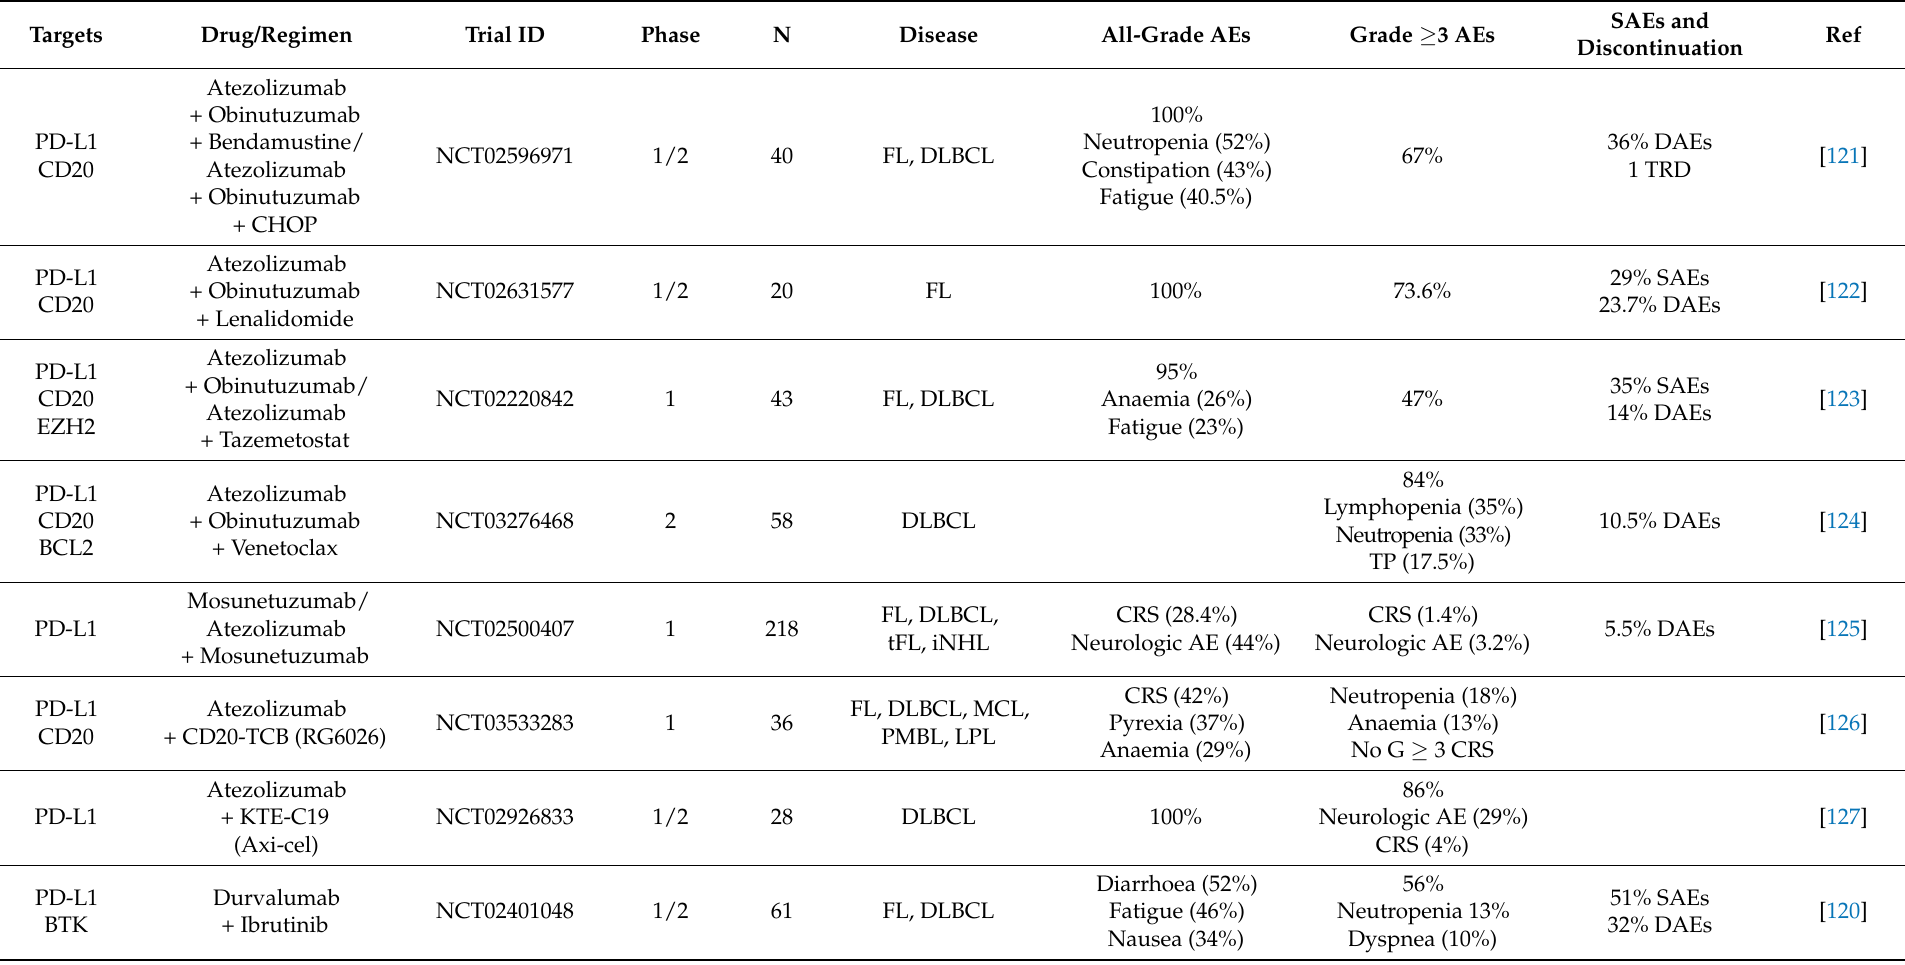
Table 2. Adverse events of immune-checkpoint-based therapy blockade for the treatment of B-cell lymphomas.